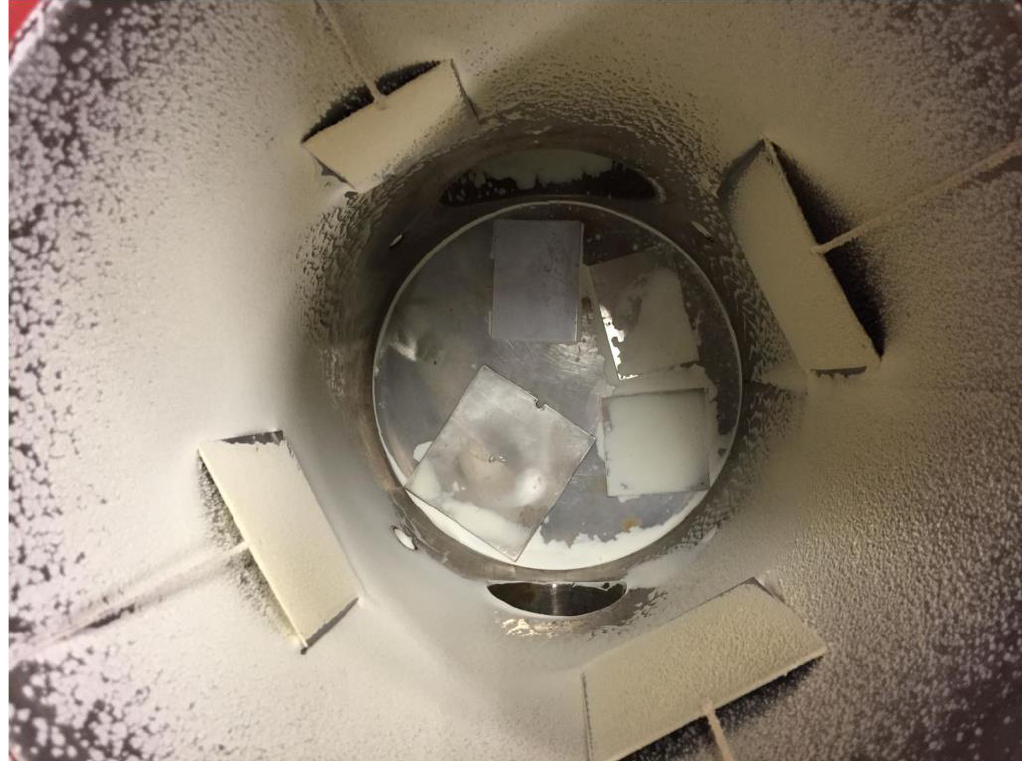
Figure 4. Current deposition pattern in unit 5 when running 8.8% milk powder at 170 °C.